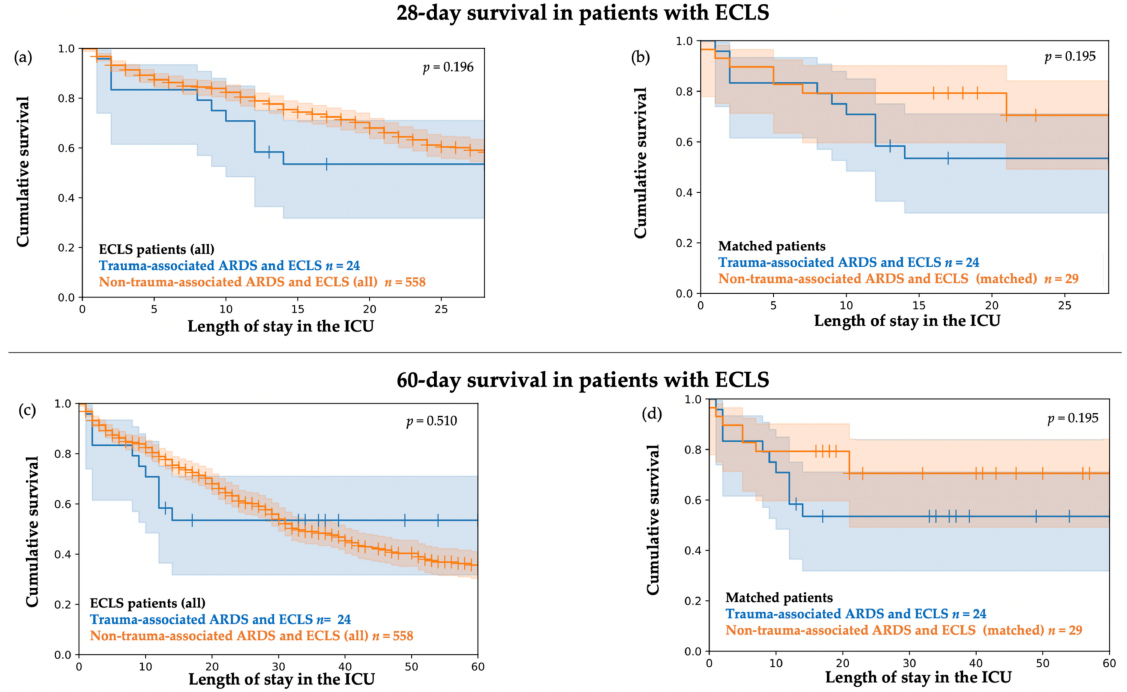
Figure 4. Kaplan–Meier plots. Cumulative 28-day and 60-day survival with 95% CI in the sub- cohort of patients with extracorporeal lung support (ECLS). ( a ) Cumulative 28-day survival in n = 24 patients with trauma-associated ARDS and ECLS treatment compared to n = 558 patients with non- trauma-associated ARDS and ECLS treatment. Tarone–Ware Test p = 0.196. ( b ) Cumulative 28-day survival in n = 24 patients with trauma-associated ARDS and ECLS treatment compared to n = 29 matched patients with non-trauma-associated ARDS and ECLS treatment. Tarone–Ware Test p = 0.195. ( c ) Cumulative 60-day survival in n = 24 patients with trauma-associated ARDS and ECLS treatment compared to n = 558 patients with non-trauma-associated ARDS and ECLS treatment. Tarone–Ware Test p = 0.510 ( d ) Cumulative 60-day survival in n = 24 patients with trauma-associated ARDS and ECLS treatment compared to n = 29 matched patients with non-trauma-associated ARDS and ECLS treatment. Tarone–Ware Test p =